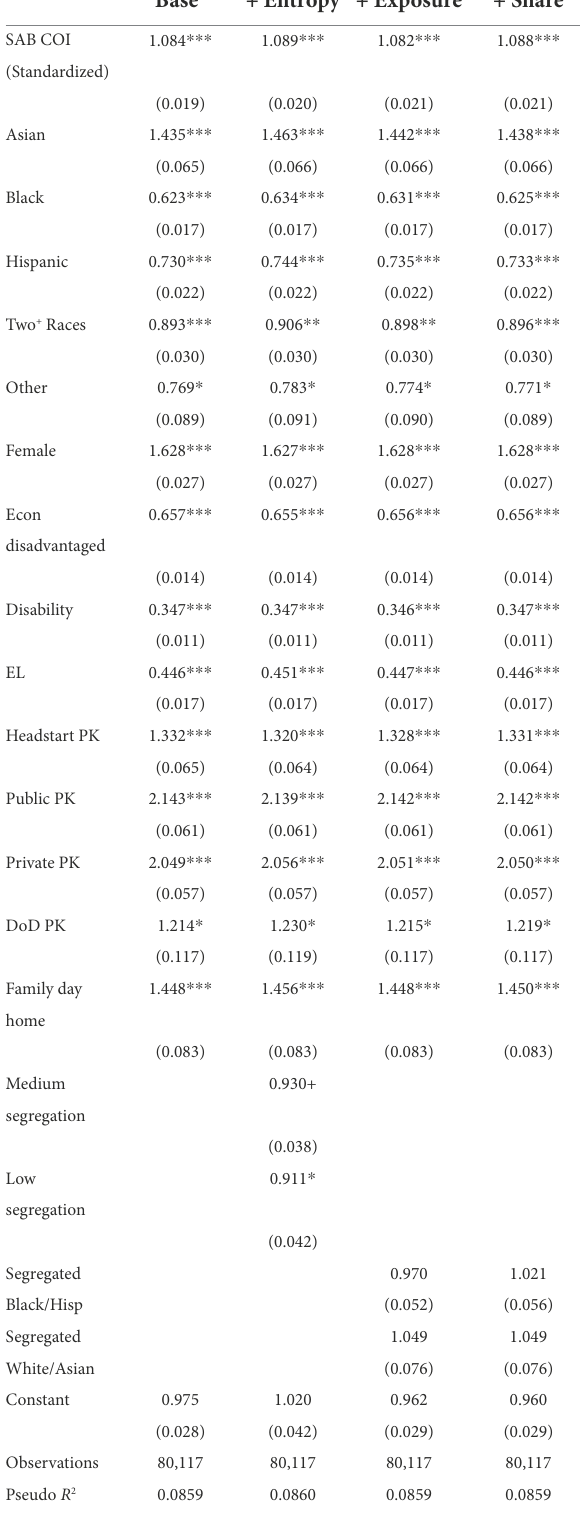
TABLE 5 Selected estimated coefficients as odds ratio from models predicting school readiness.